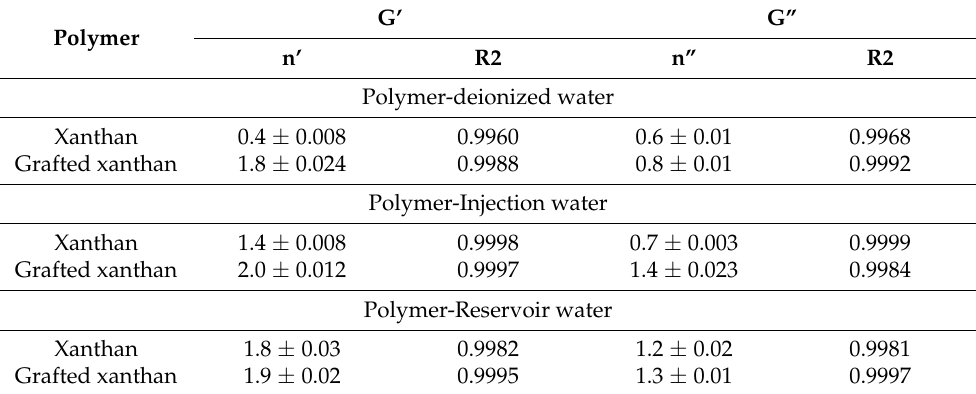
Table 9. Values of the power dependence of G’ and G”